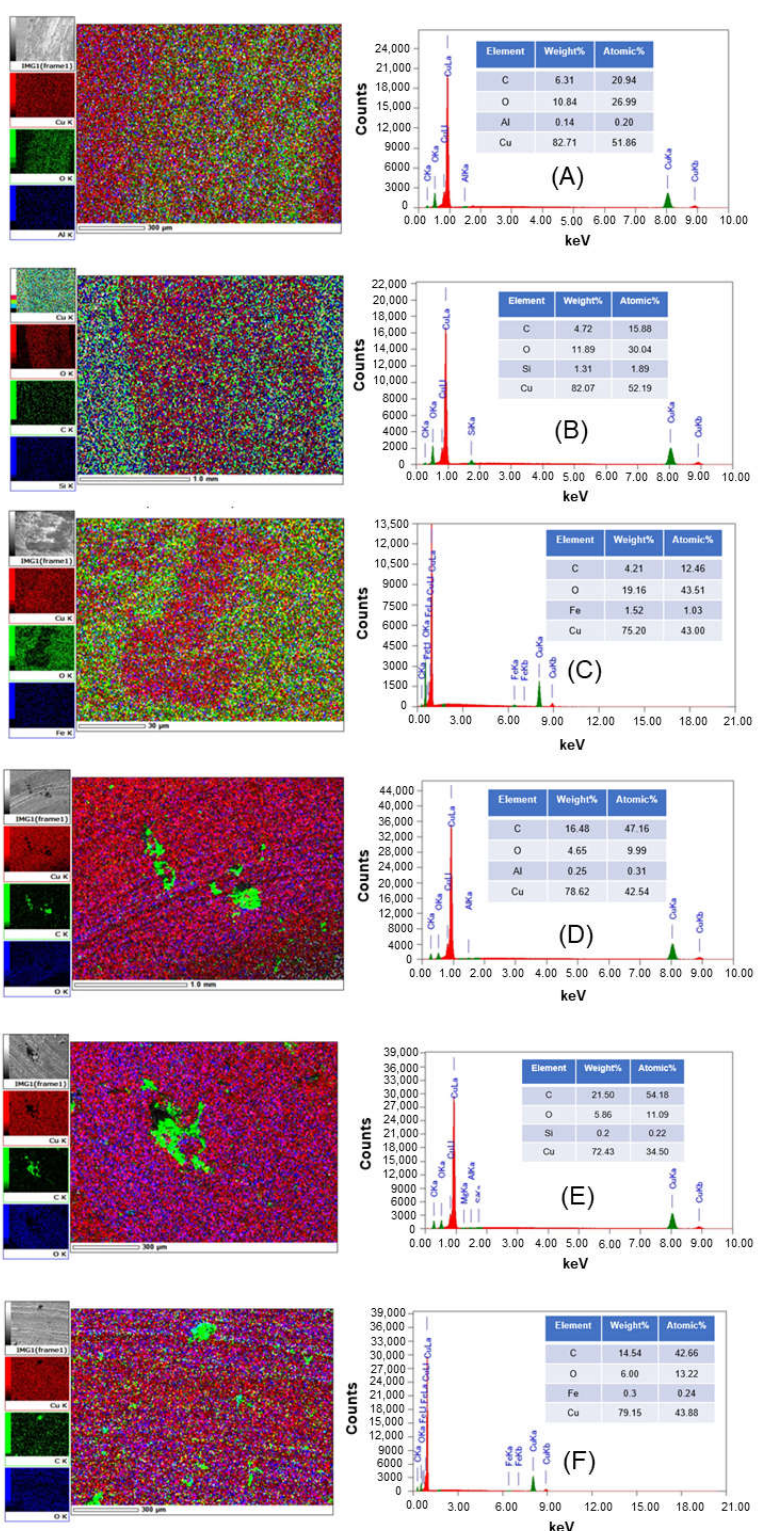
Figure 9. EDS analysis of the worn surface of the sintered discs that sliding against different counterbodies ( A ) Cu/Al 2 O 3 ; ( B ) Cu/SiC; ( C ) Cu/SuJ2; ( D ) Cu-MgPG/Al 2 O 3 ; ( E ) Cu-MgPG/SiC; ( F ) Cu- MgPG/SuJ2.